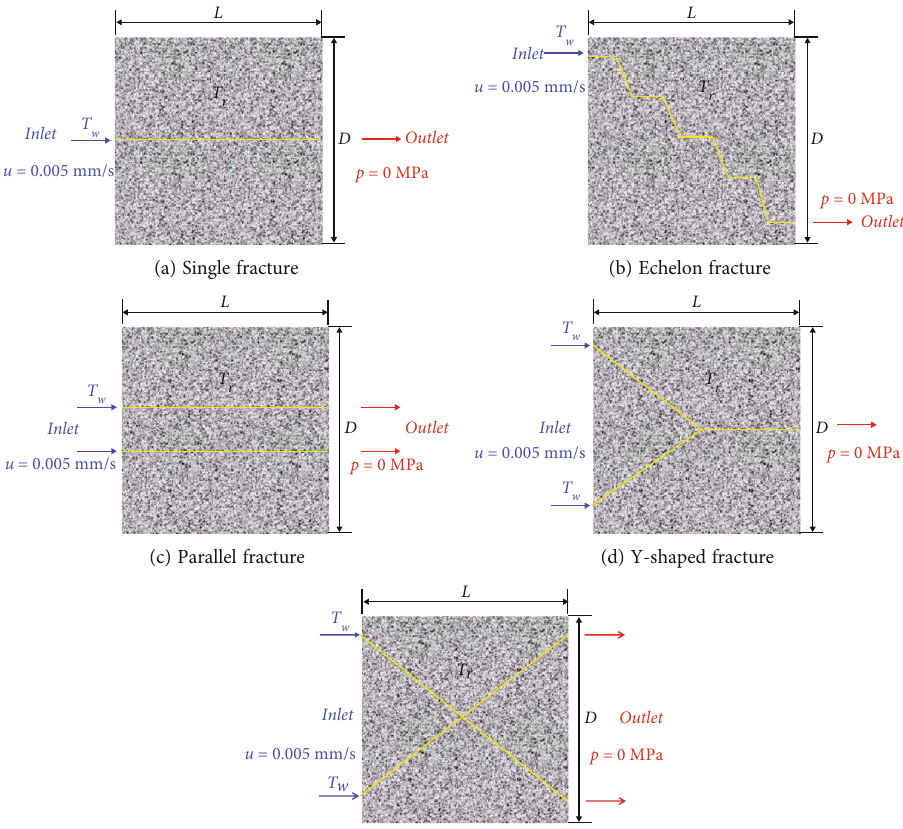
Figure 2: Two-dimensional fracture model with di ff erent fracture